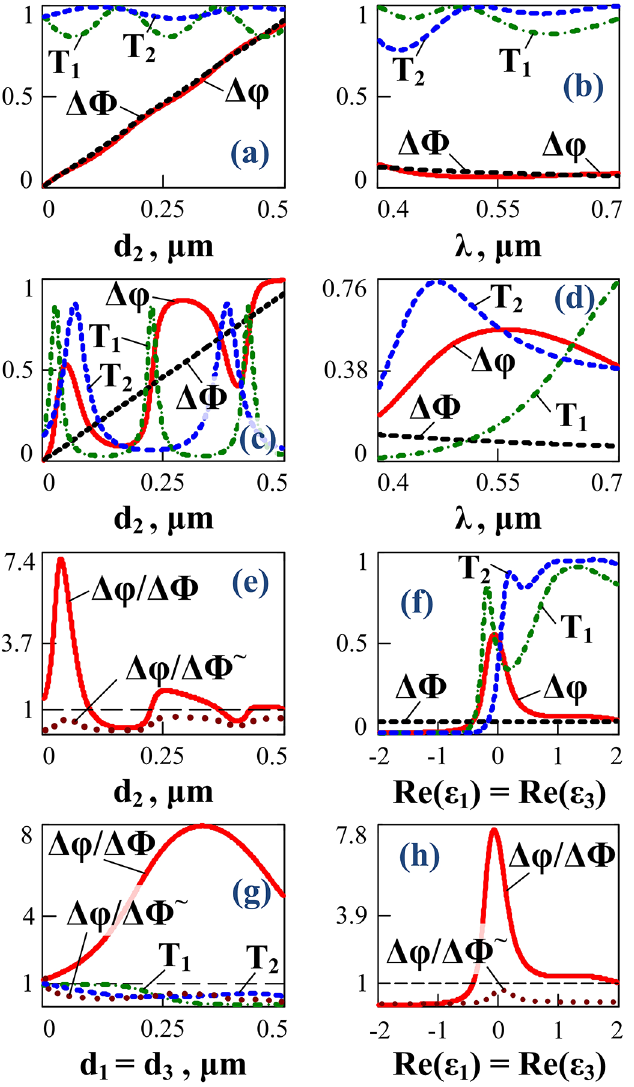
Fig. 4. Dependences of PSD D ’ , DF , relations D ’ / DF , D ’ / DF ∼ and energy transmission coef fi cients T 1,2 of waves 1, 2 on the main layer thickness d 2 (a, c, e), wavelength l (b, d), parameters e 0 (f, h), d 1,3 (g) for various materials of layers 1, 3. The values 1 ; 3 of parameters are: e 1 = e 3 = 2+ 10 (cid:1) 3 i (a, b); e 1 = e 3 =0.01 +0.01 i ¼ 0 : 01 (f, h). The values of (c, d, e, g); d 2 = 39nm (b, d, f, h); e 00 1 ; 3 parameters for all the graphs are: d 1,3 = 0.25 m m (besides g); l =0.63 m m (besides b, d). Figures e and h detail the data in Figures c and f, respectively. The black horizontal dashed line in Figures e, g, h characterize equality to 1 of the corresponding quantities.